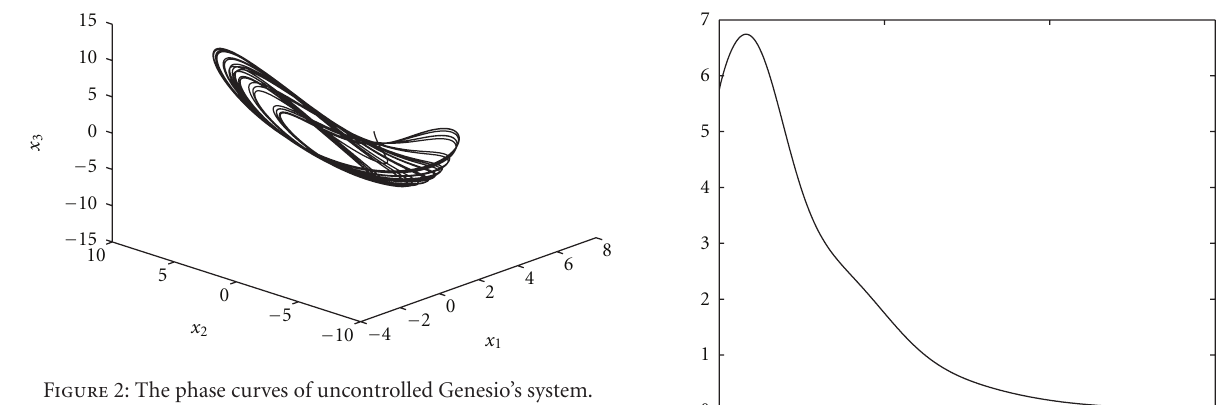
Figure 2: The phase curves of uncontrolled Genesio’s system.